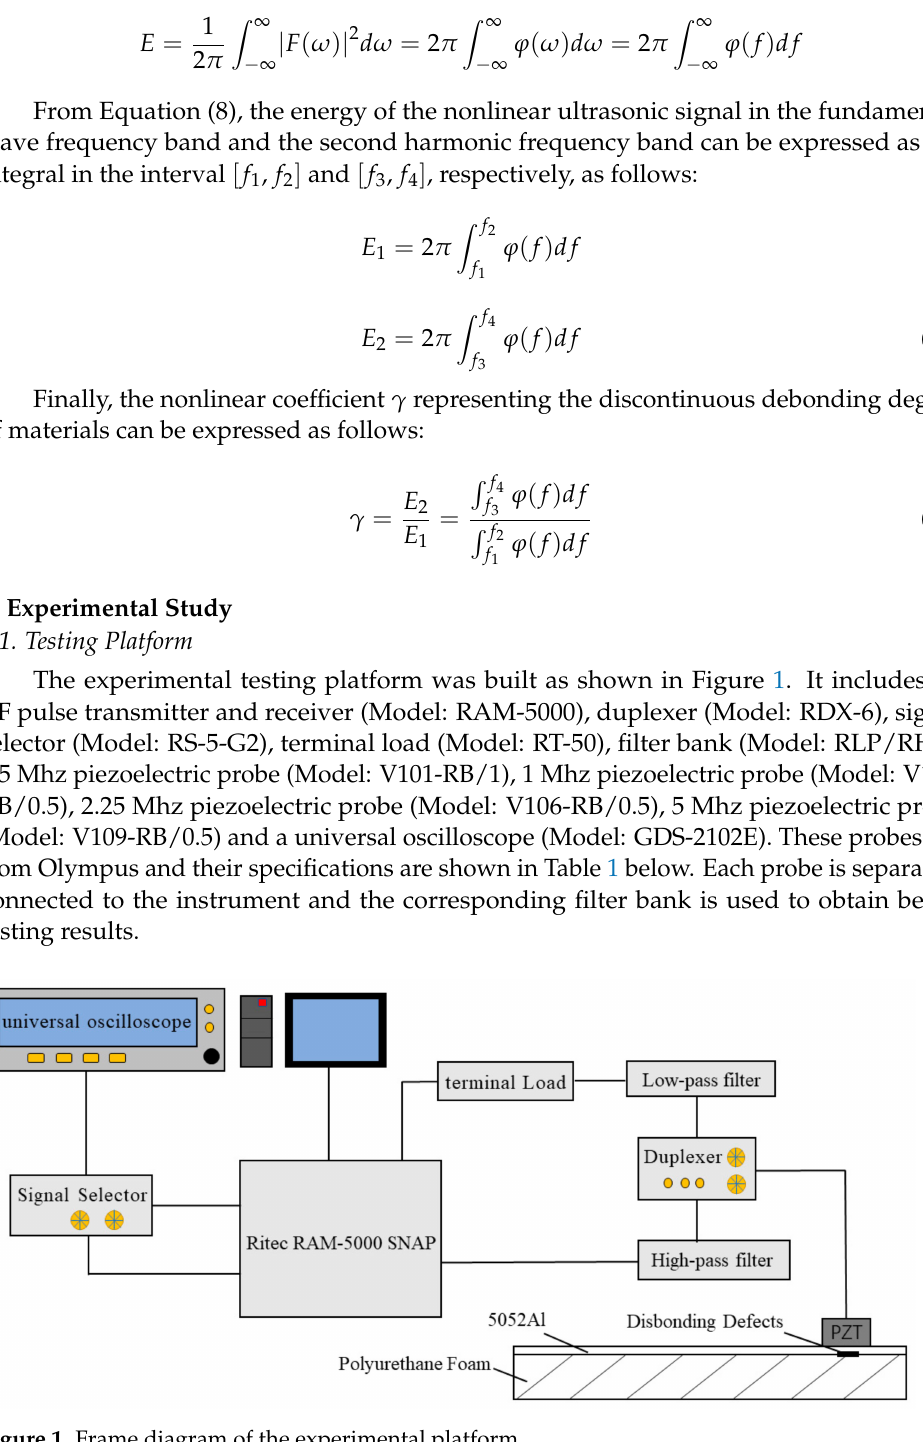
Figure 1. Frame diagram of the experimental